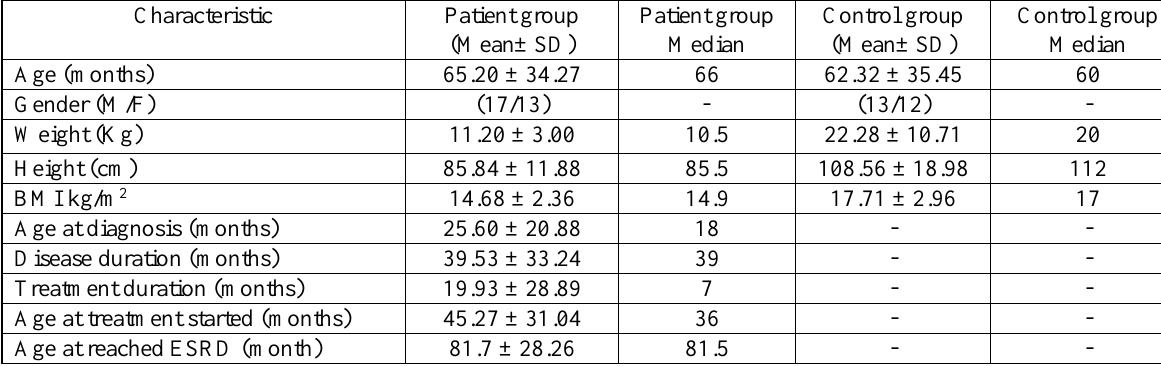
N for patients=30, N for Control=25, SD=Standard deviations, M=Male, F=Female, BMI= body mass index, ESRD=End stage renal